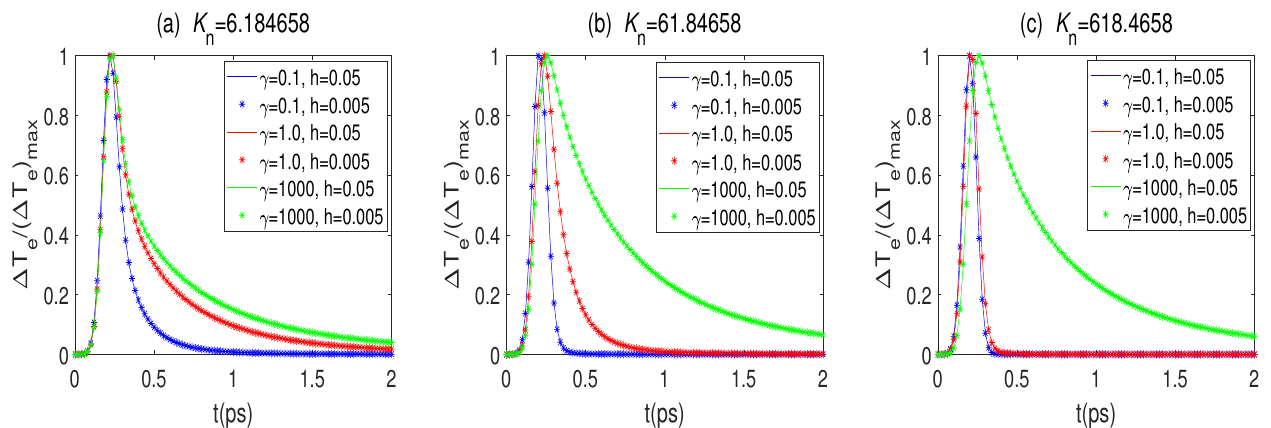
Figure 2. Changes in electron temperature ∆ T e / ( ∆ T e ) max and various K n , γ , and ( α , β ) = ( 0.9,0.9 ) .